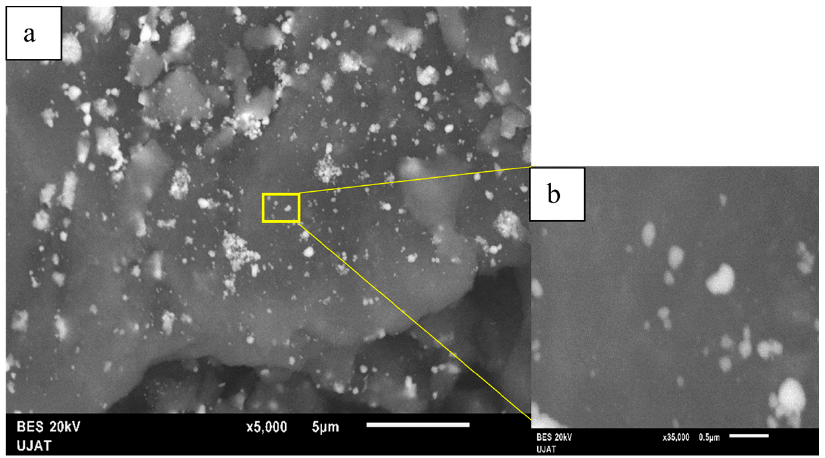
Figure 4. SEM images of AgCuAlCe ( a ) 5000X and ( b ) 35000X.